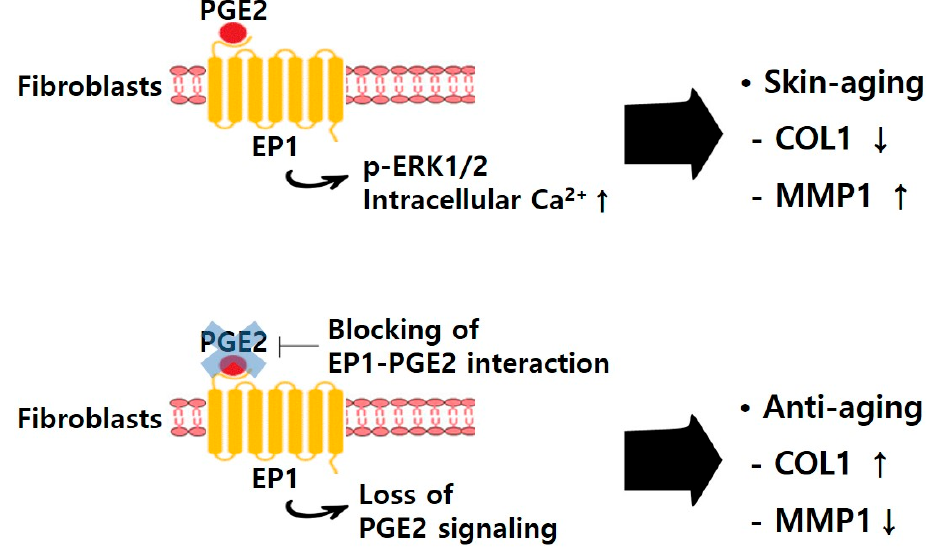
Figure 6. Schematic model for the mechanism contributing to beneficial effects of blocking EP1–PGE2 interaction in NHDFs. ↑ , increase; ↓ , decrease.